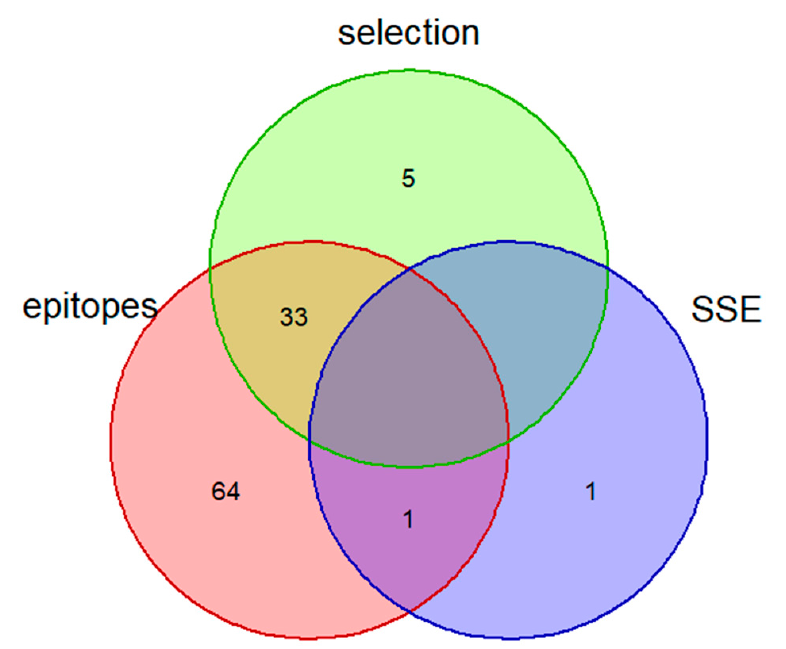
Figure 4. Venn diagram depicting the overlap between the Nextclade private mutations in HLA epitopes, under evolutionary selection and causing changes in secondary structure elements (SSE) observed in the Armenian samples (n = 145).